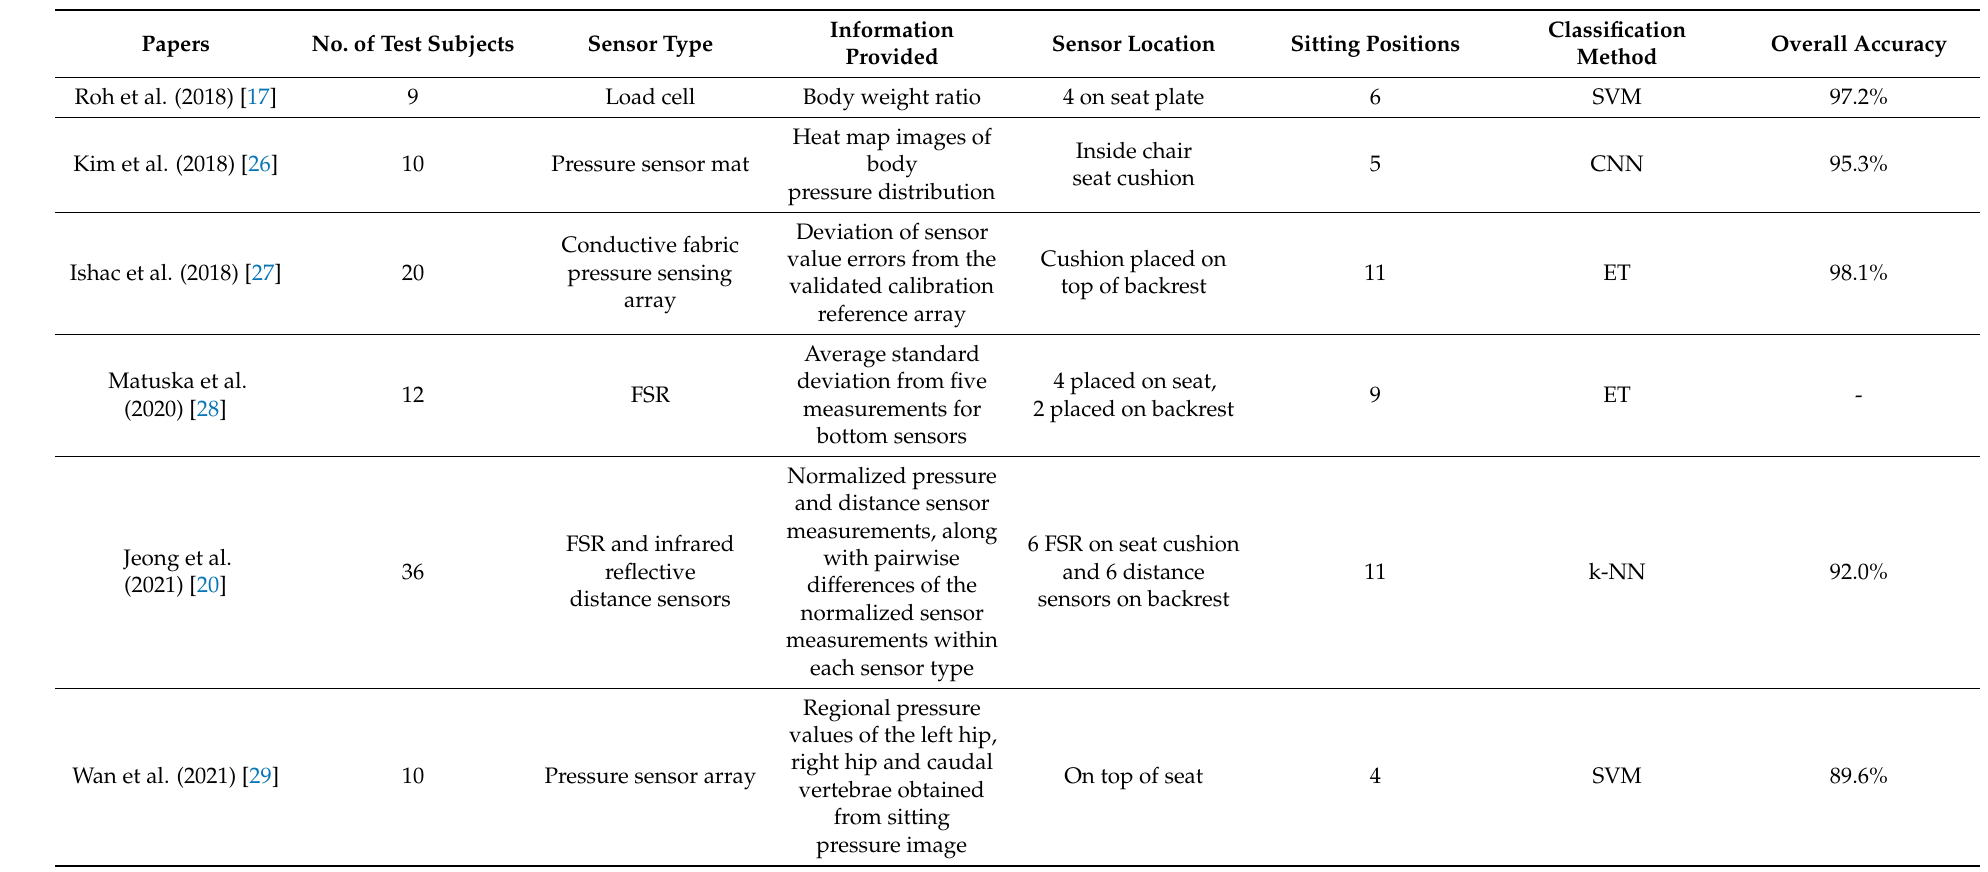
Table 2. Posture monitoring systems proposed in the literature